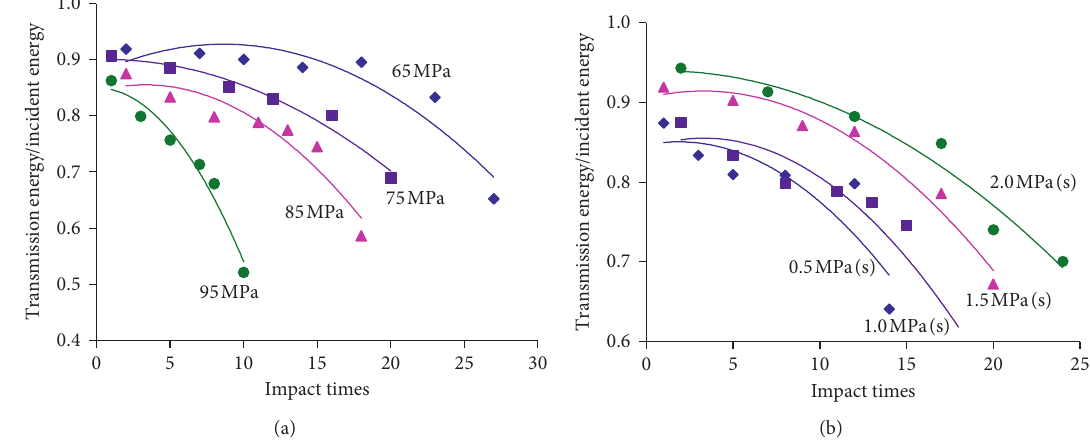
Figure 13: Change law of the ratio of transmission energy to incident energy with the increase of disturbance impact times: (a) unloading rate is 1.0MPa/s (the numbers in figure represents the preloaded axial static stress of specimen); (b) the preloaded axial pressure is 85MPa (the number in the figure represents the unloading rate).